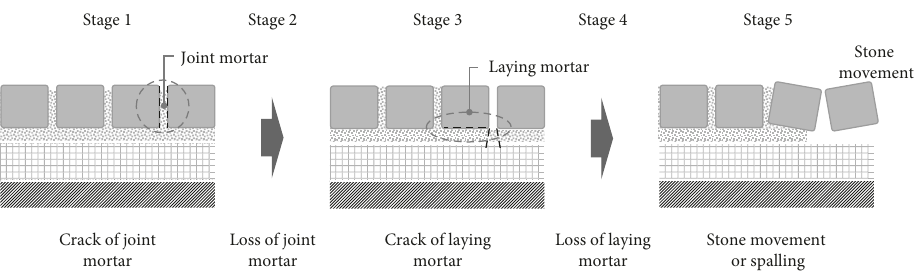
Figure 2: Damaging progress of stone